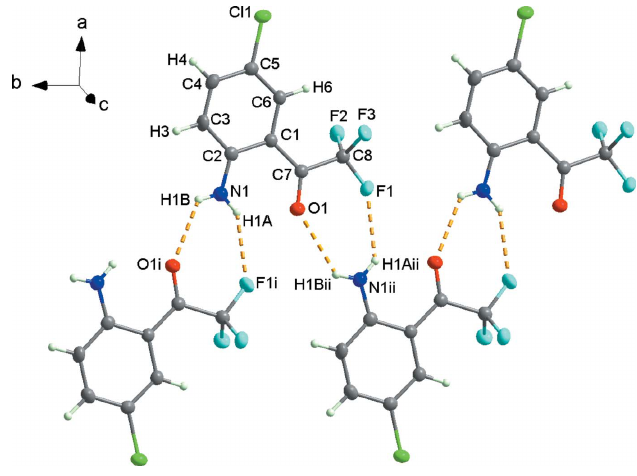
Figure 1 The molecular structure and hydrogen-bonding interactions of the title compound. Symmetry codes: (i) (cid:5) x , 1